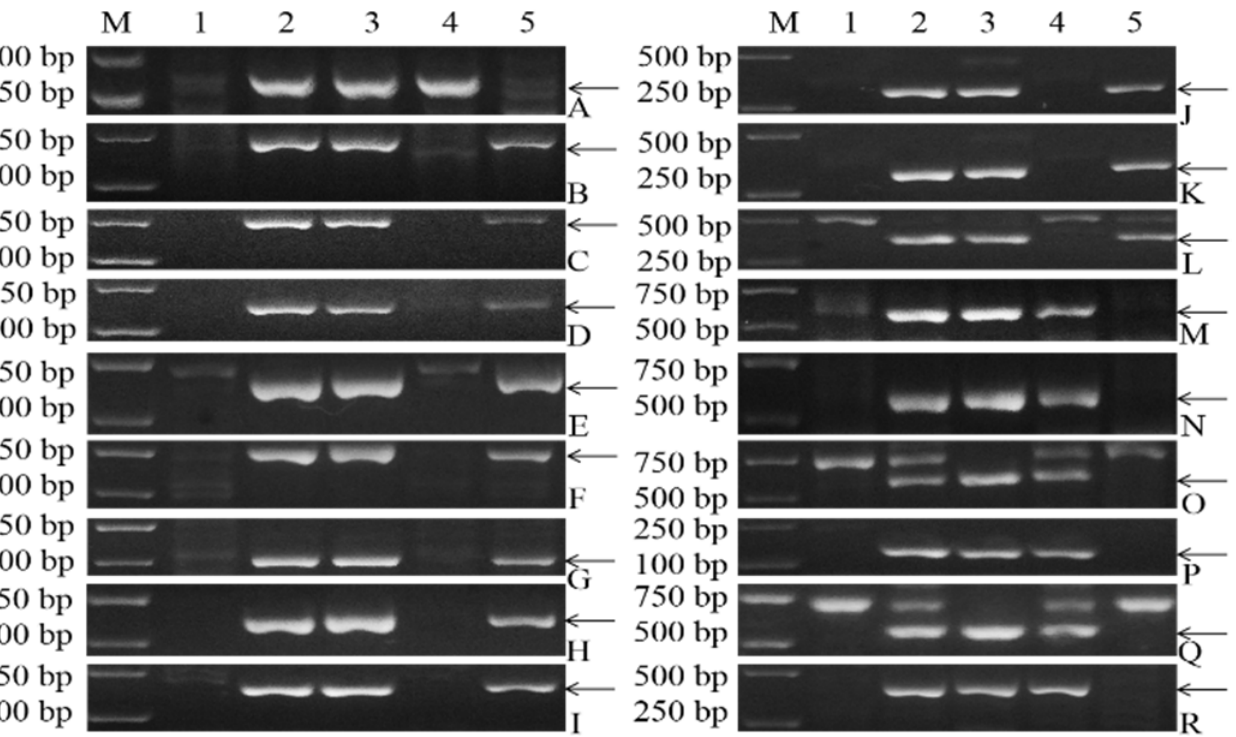
Figure 5. PCR patterns of 18 primers 3V#4 for wheat- D. villosum translocations and their parents. M indicates Trans2K plus DNA marker, 1–5 are CS, CD-3, D. villosum accession PI 491576, 22-12 and 24-20, respectively. ( A – R ) Markers 3V#4-1, 3V#4-2, 3V#4-3, 3V#4-5, 3V#4-7, 3V#4-11, 3V#4-12, 3V#4- 14, 3V#4-16, 3V#4-17, 3V#4-18, 3V#4-19, 3V#4-20, 3V#4-21, 3V#4-22, 3V#4-24, 3V#4-26, 3V#4-27. The arrows show D. villosum -specific bands.